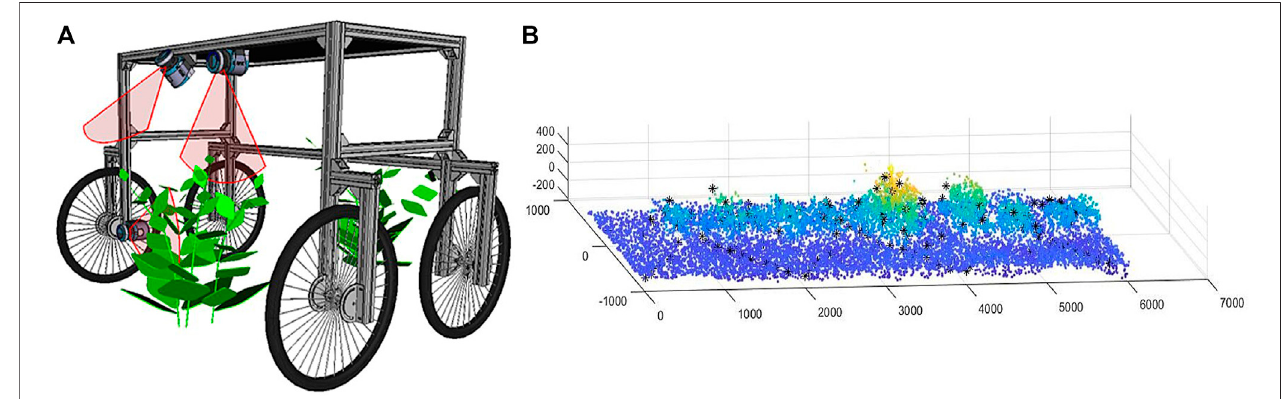
FIGURE2|(A) Arrangelasersensorsontheplatformandcoveragerangeforthepointcloudacquisitionprocess (B) Partialreconstructionofacroprowaccording to the advance of the robotic platform.